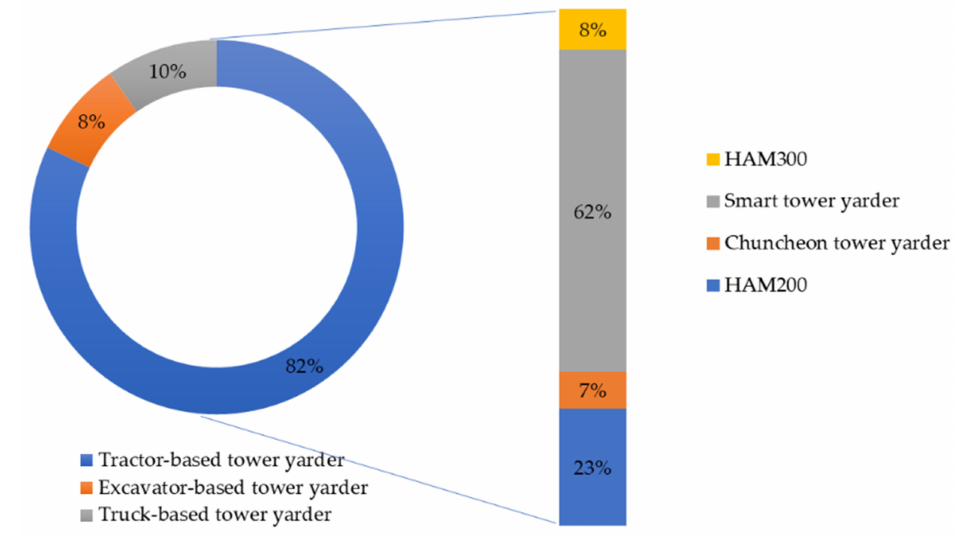
Figure 1. Distribution of the tower yarders in Korea, 2019. Table 1. Summary of specific harvest information and productivity results from previous cable extraction activities